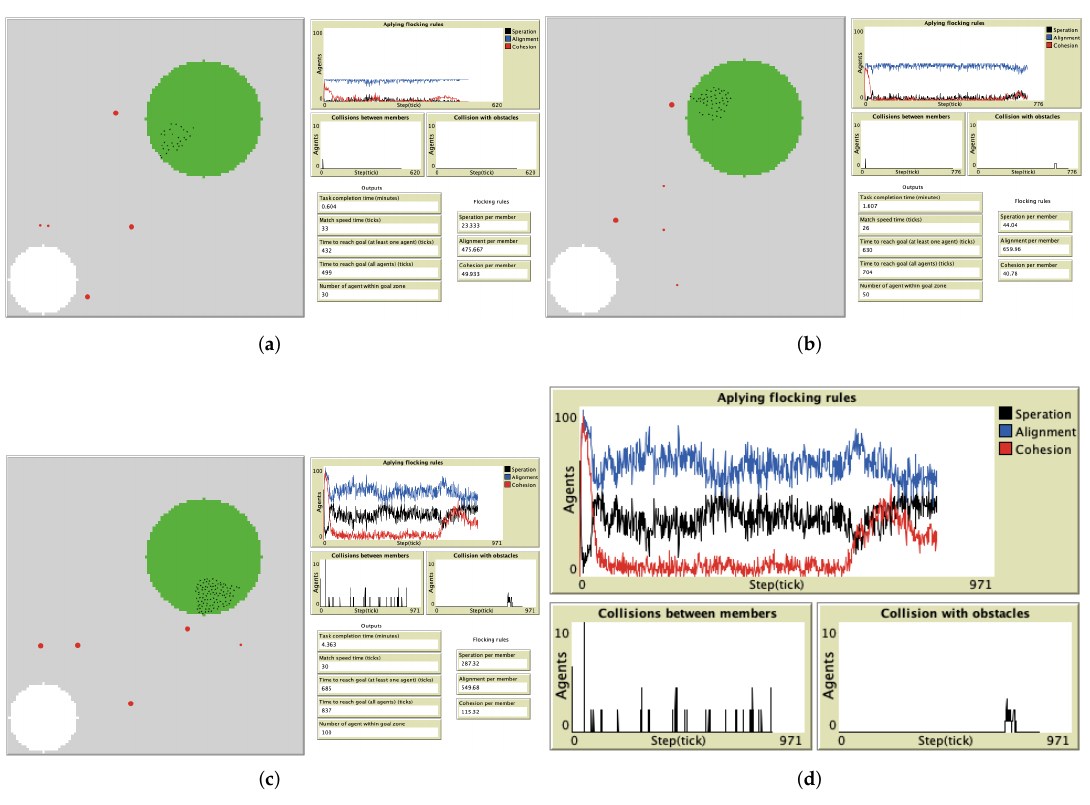
Figure 7. Snapshots of simulation experiments with flock sizes of 30, 50, and 100, in an environment with obstacles. ( a ) Experiment 1 with 30 agents. ( b ) Experiment with 50 agents. ( c ) Experiment with 100 agents. ( d ) Focus on the flocking rules and number of collisions for experiment with 100 agents. (Figure